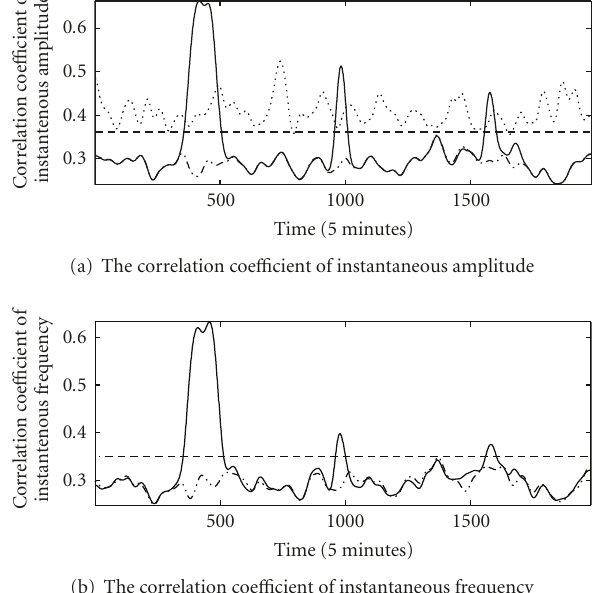
Figure 11: The detection results of nonperiodic DDoS attacks.